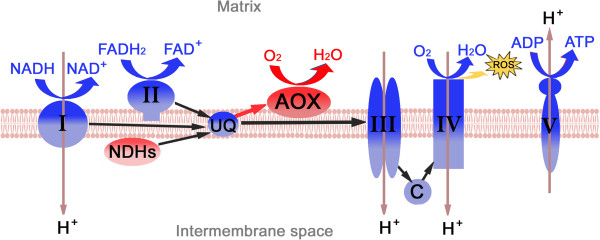
Class 2 involved in cellular respiration and election transport chain in plant mitochondria. Genes involved in a classical cytochorme c oxidase (COX) respiration pathway generating energy and ROS were down-regulated (blue), whereas genes involved in alternative oxidase respiration pathways were up-regulated (red) in the im mutant fibers. AOX, alternative oxidase; I, NADH:dehydrogenase or NADH-plastoquinone oxidoreductase; II, succinate:ubiquione oxidoreductase; III, cytochorme bc1 complex; IV, cytochrome c oxidase; V, ATP synthase; NDHs, rotenone-insensitive NAD (P) H dehydrogenase; ROS, reactive oxygen species; UQ, ubiquione pool.